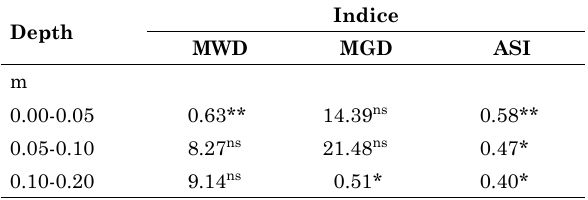
table 4. pearson correlation between the total organic carbon concentration throughout the soil and the soil aggregation indices mWd (mean weight diameter), mgd (mean geometric diameter), and ASi (aggregate stability index) at different